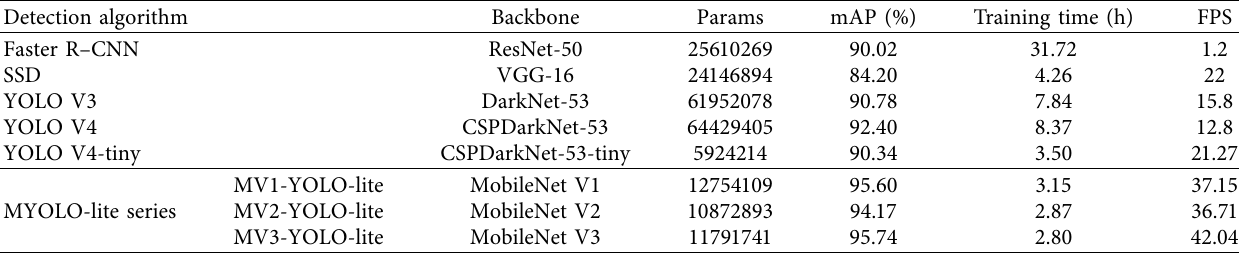
Table 4: Performance comparison of different network